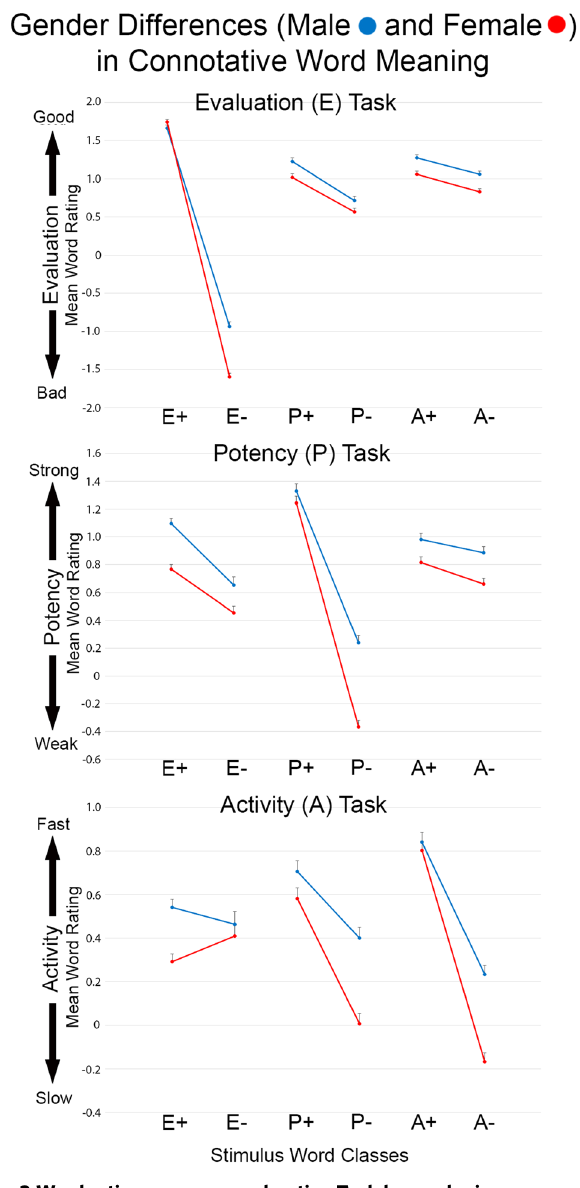
Fig. 3 Word rating means on each rating Task by gender in our group of 94 young adults. The words are grouped into Word-Classes by their largest positive or negative connotative word rating on each of the three word rating Tasks (E, P, and A) as compiled by Heise and Snider and Osgood (Chapman, 1978a). Error bars represent standard error of the mean